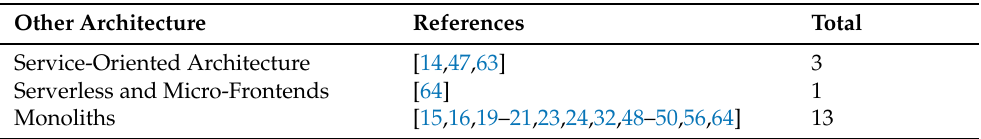
Table 7. Works relevant to